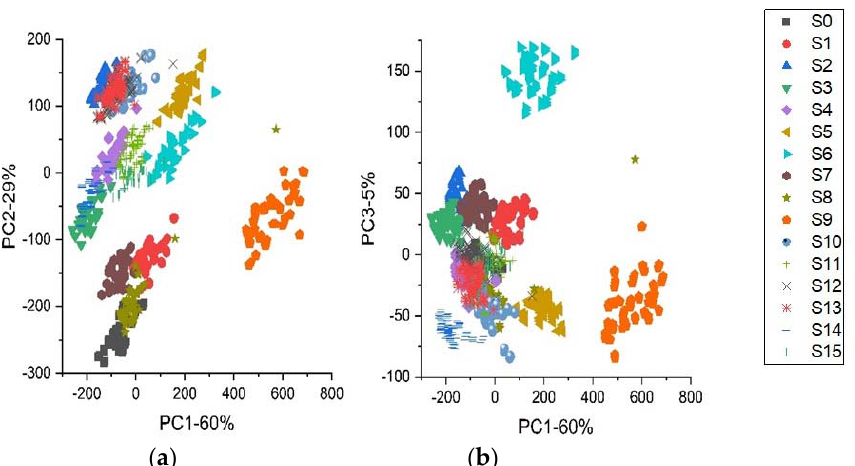
Figure 2. Principal Components (PCs) distribution diagrams of individual samples. ( a ) PC1-PC2; ( b ) PC1-PC3.